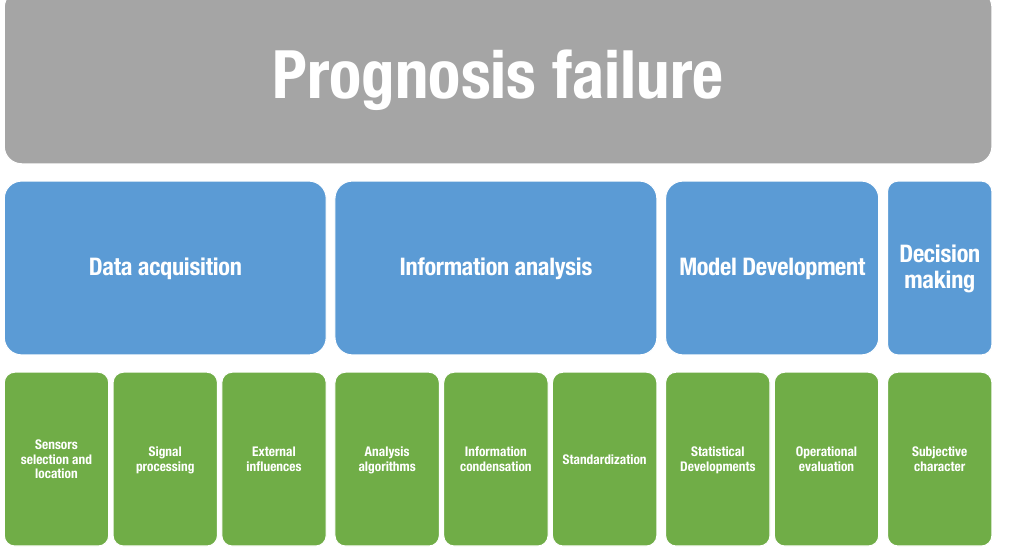
Figure 4. Prognosis failure